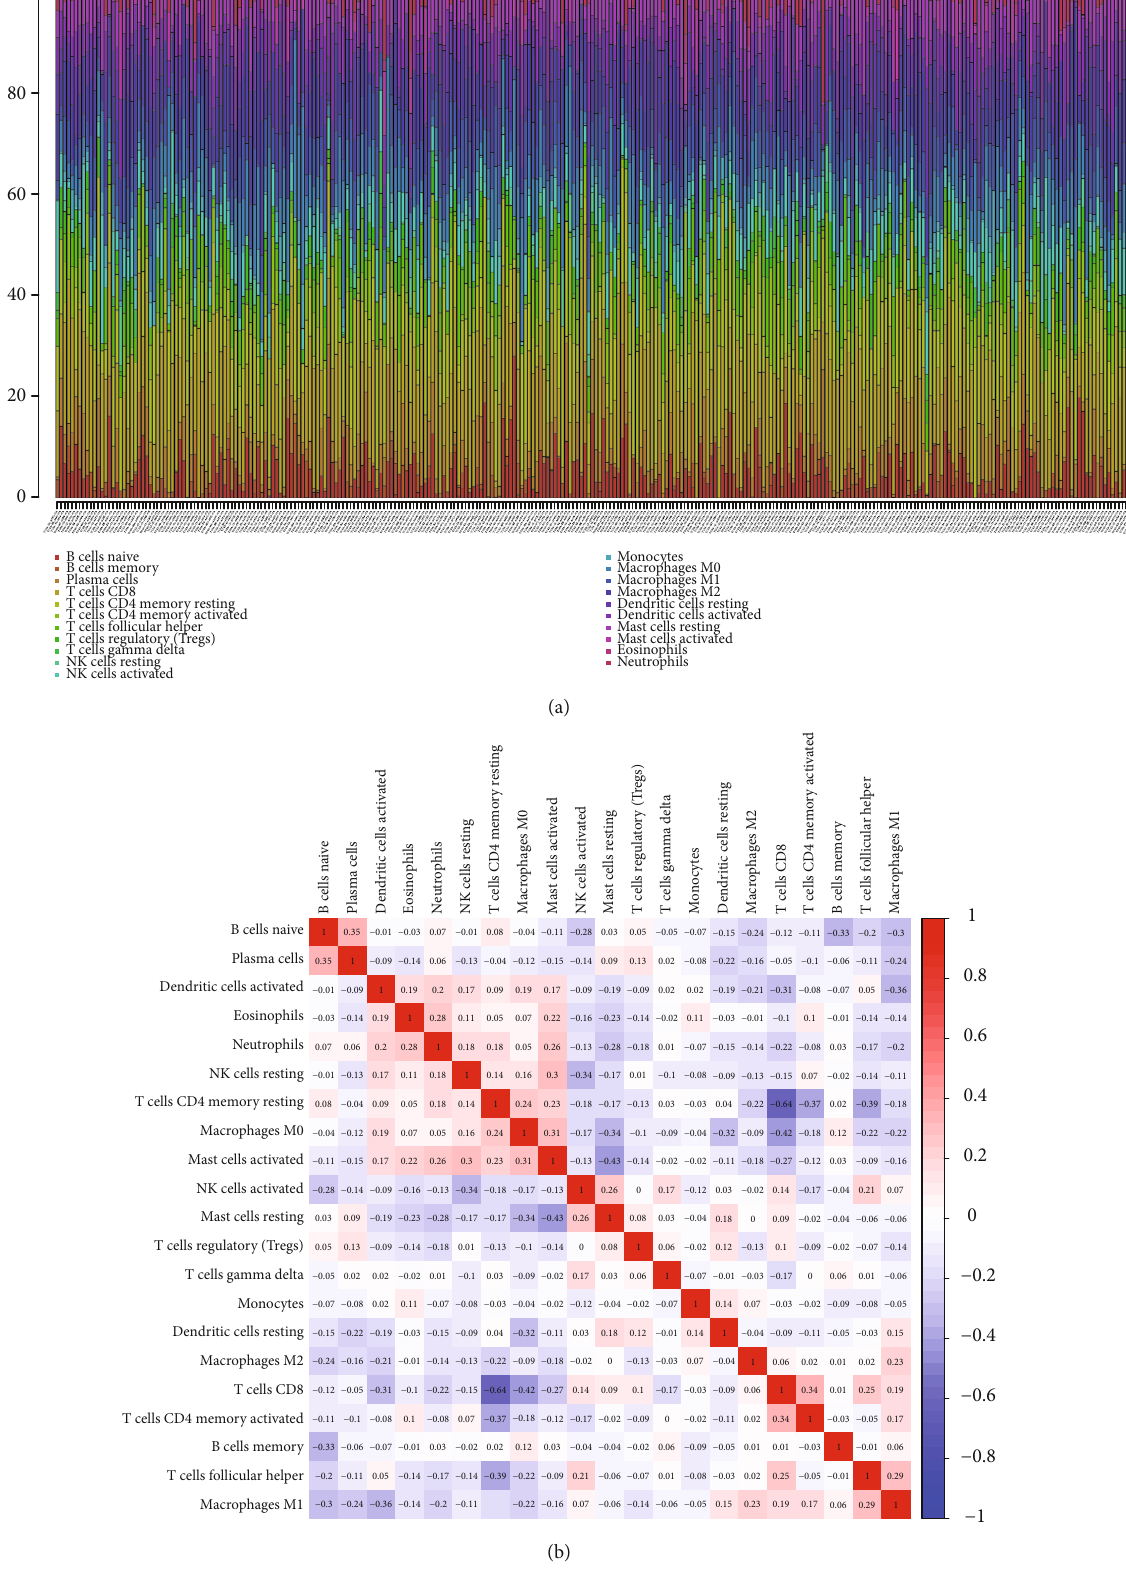
Figure 7: (a) The abundance of 22 in fi ltrating immunocyte subtypes in tumorous and normal biopsies for TCGA-CESE cohorts computed by the CIBERSORT approach. (b) Pearson correlation coe ffi cient was utilized to study the matrix of 22 kinds of TIICs in pulmonary